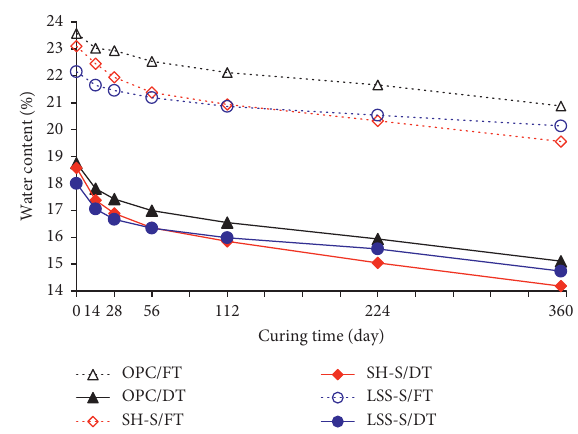
Figure 6: Effect of AAS and DTon the water content levels of CPBs over curing time.